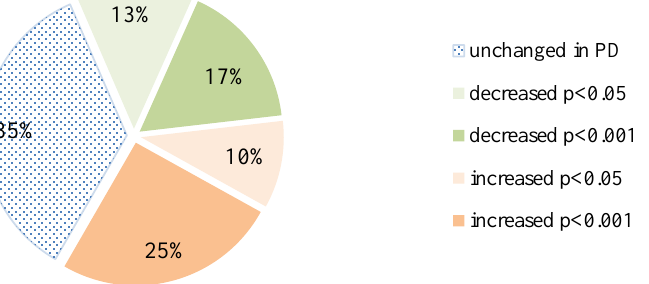
Calculated “ p ” values; statistically significant data are labelled as follows: green color represents a decrease in patients on peritoneal dialysis (PD), red color represents an increase in patients on PD.